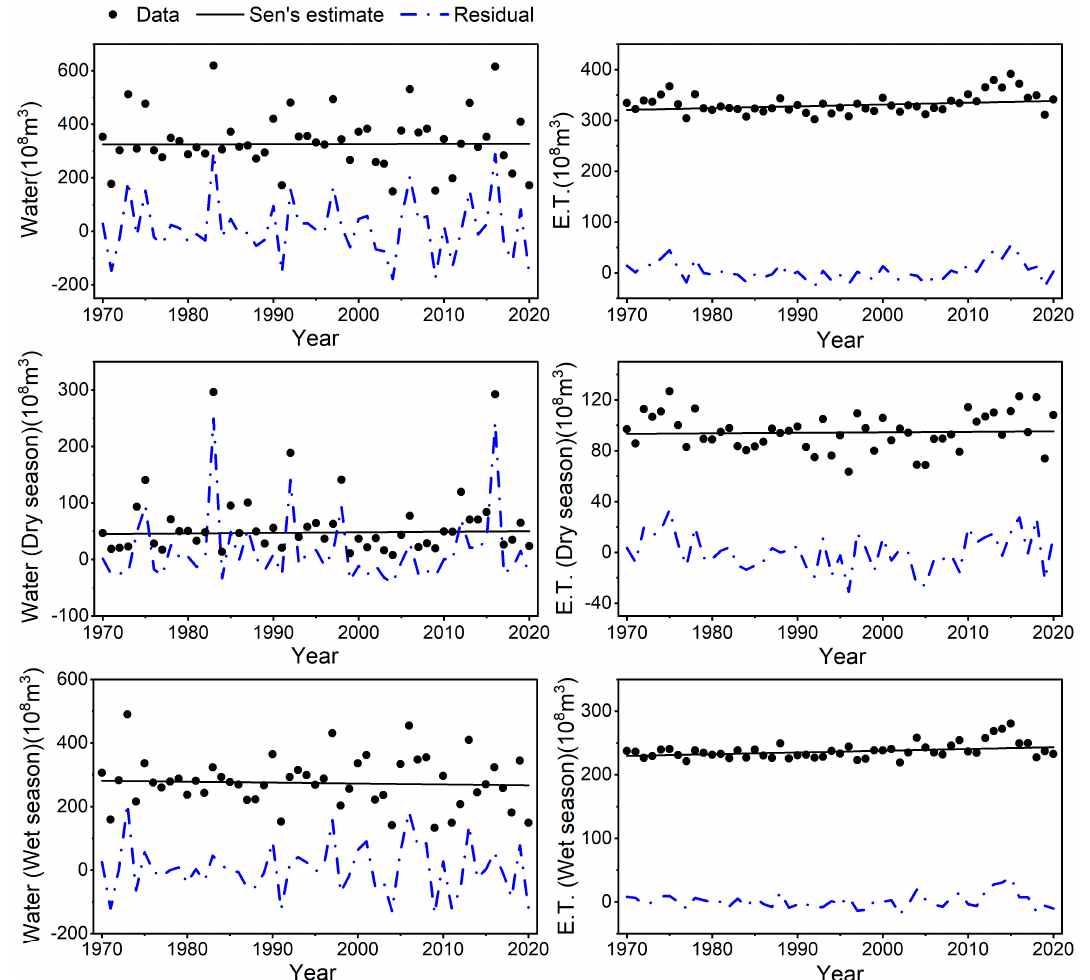
Figure 4. Variation trend of water resources and evapotranspiration from 1970 to 2020. Table 2. M-K test, S-M-K test, S-E test and Hurst index of each element from 1970 to 2020. Element